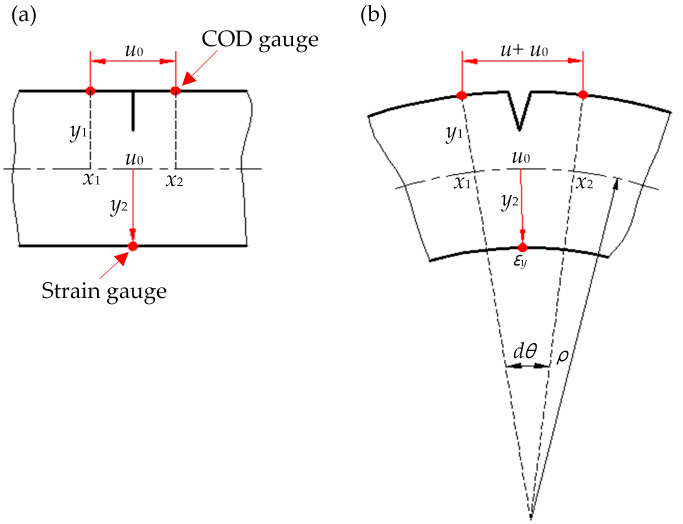
Figure 1. The geometric deformation of the cracked beam section: ( a ) undeformed, ( b ) deformed. COD: crack opening